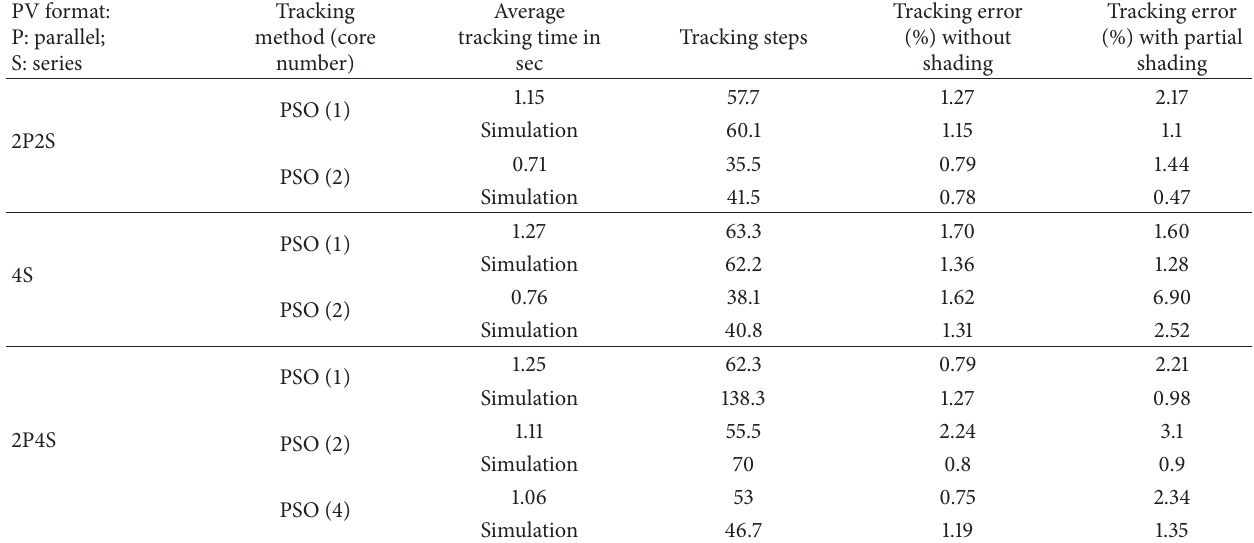
Table 8: Tracking time and error for the proposed multicore PSO MPPT operation: simulation versus